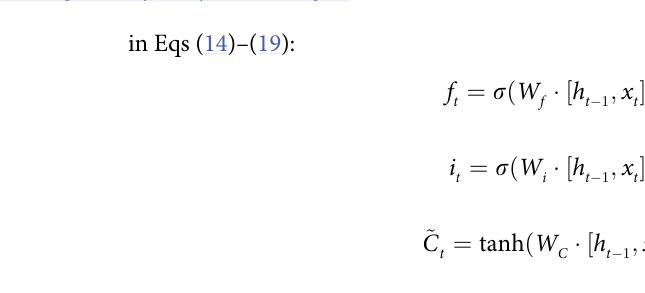
Fig 3. Comparison of RNN and LSTM structures (a. RNN; b. LSTM).